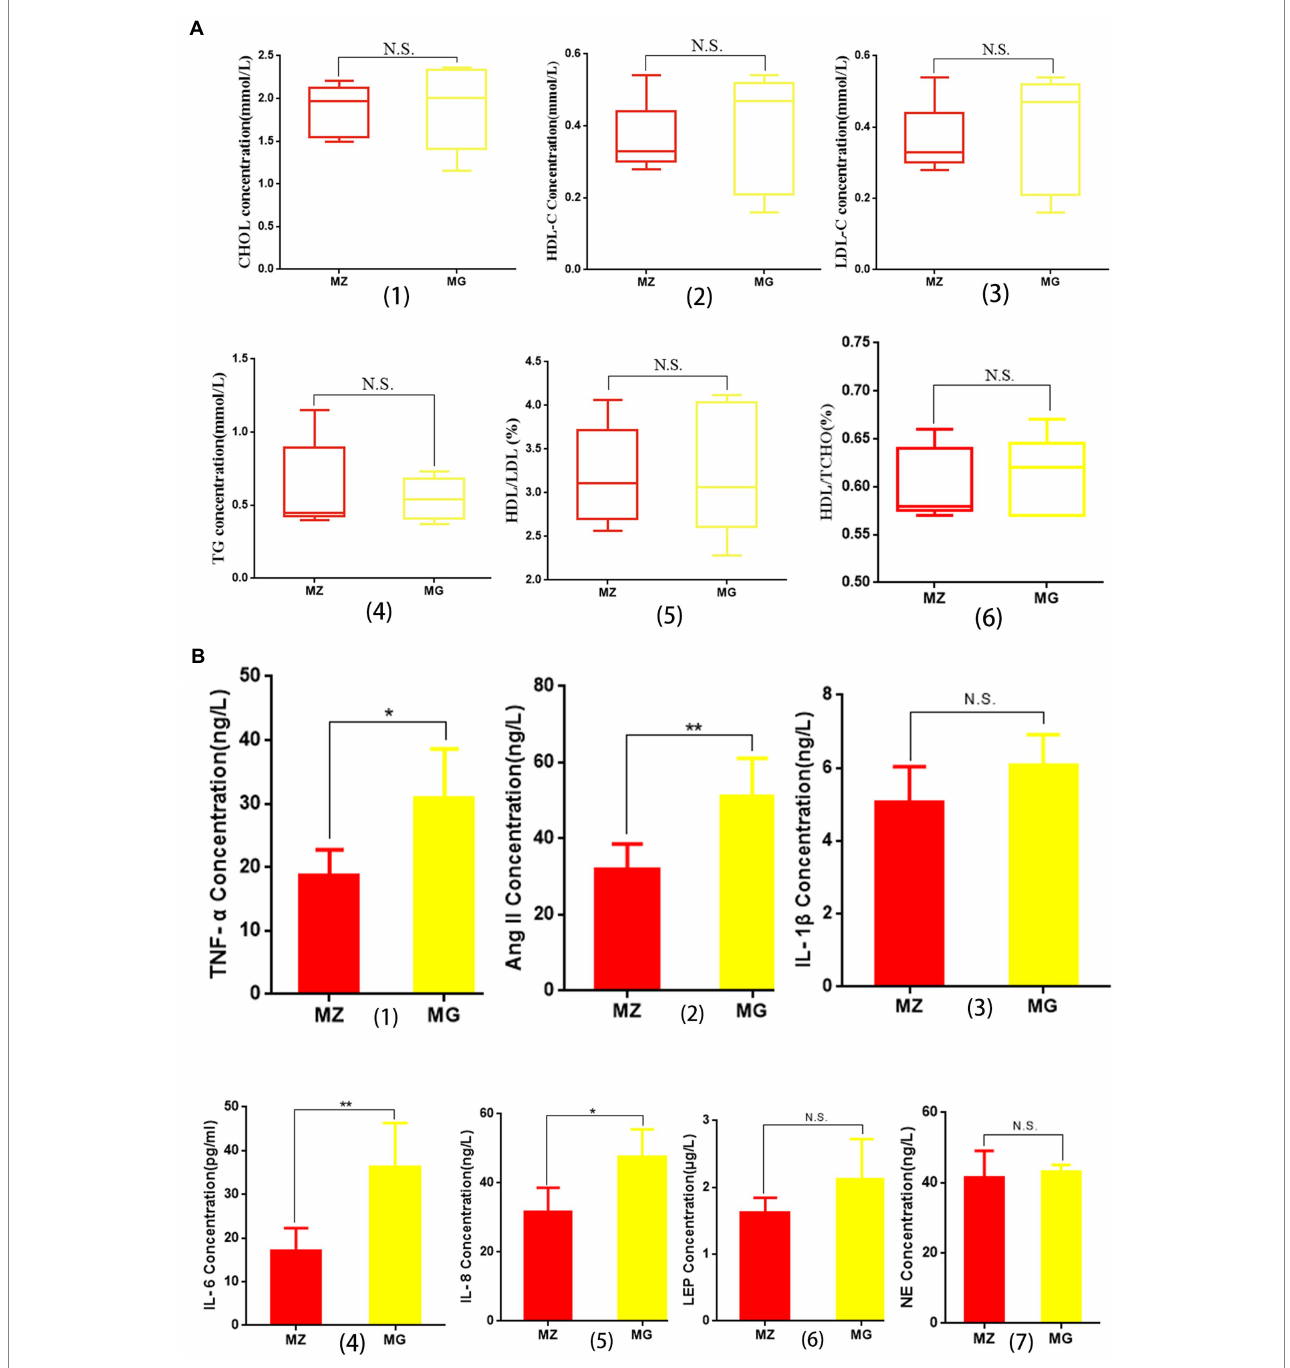
FIGURE 2 Effects of high salt diet on blood lipids and inflammatory cytokines and hormones related to hypertension in rats. (A) Changes of blood lipid in MZ group and MG group. (B) Changes in inflammatory cytokines and hormones associated with hypertension in MZ and MG groups. MZ, normal group; MG, hypertensive